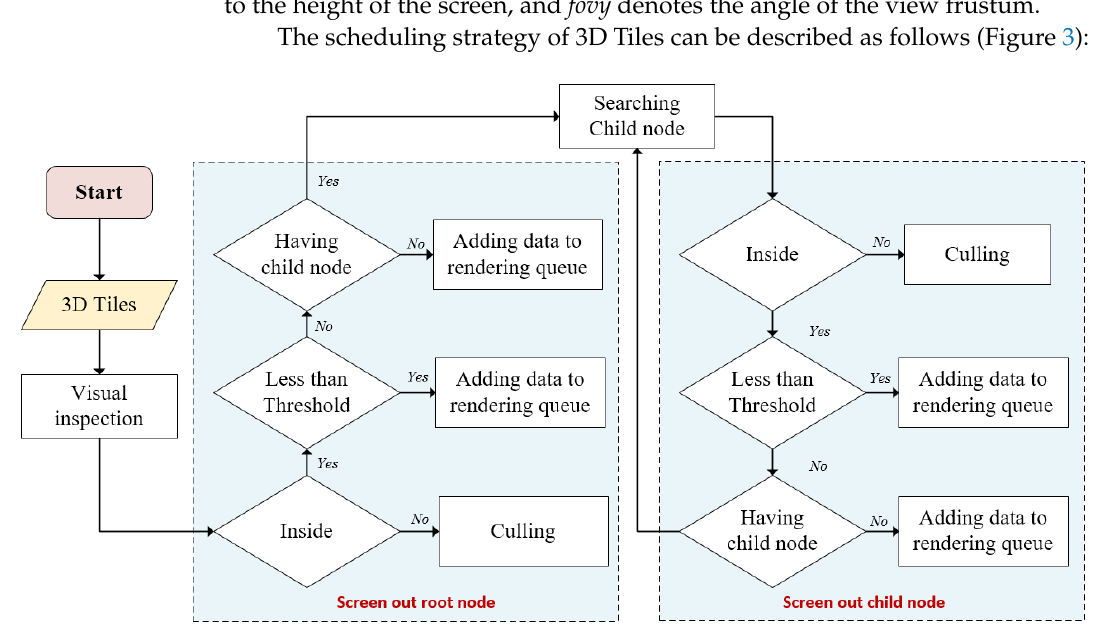
Figure 3. Scheduling strategy of 3D Tiles.